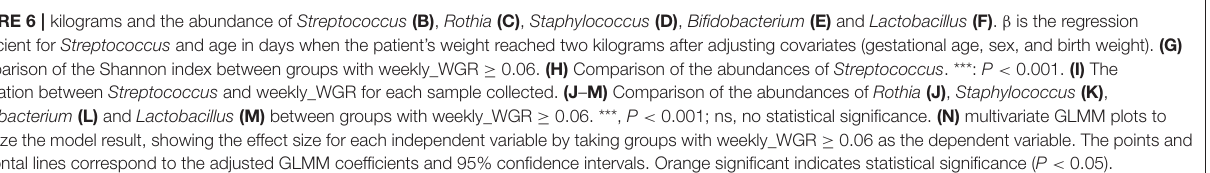
FIGURE 6 | kilograms and the abundance of Streptococcus (B) , Rothia (C) , Staphylococcus (D) , Bifidobacterium (E) and Lactobacillus (F) . β is the regression coefficient for Streptococcus and age in days when the patient’s weight reached two kilograms after adjusting covariates (gestational age, sex, and birth weight). (G) Comparison of the Shannon index between groups with weekly_WGR ≥ 0.06. (H) Comparison of the abundances of Streptococcus . ***: P < 0.001. (I) The correlation between Streptococcus and weekly_WGR for each sample collected. (J – M) Comparison of the abundances of Rothia (J) , Staphylococcus (K) , Bifidobacterium (L) and Lactobacillus (M) between groups with weekly_WGR ≥ 0.06. ***, P < 0.001; ns, no statistical significance. (N) multivariate GLMM plots to visualize the model result, showing the effect size for each independent variable by taking groups with weekly_WGR ≥ 0.06 as the dependent variable. The points and horizontal lines correspond to the adjusted GLMM coefficients and 95% confidence intervals. Orange significant indicates statistical significance ( P <